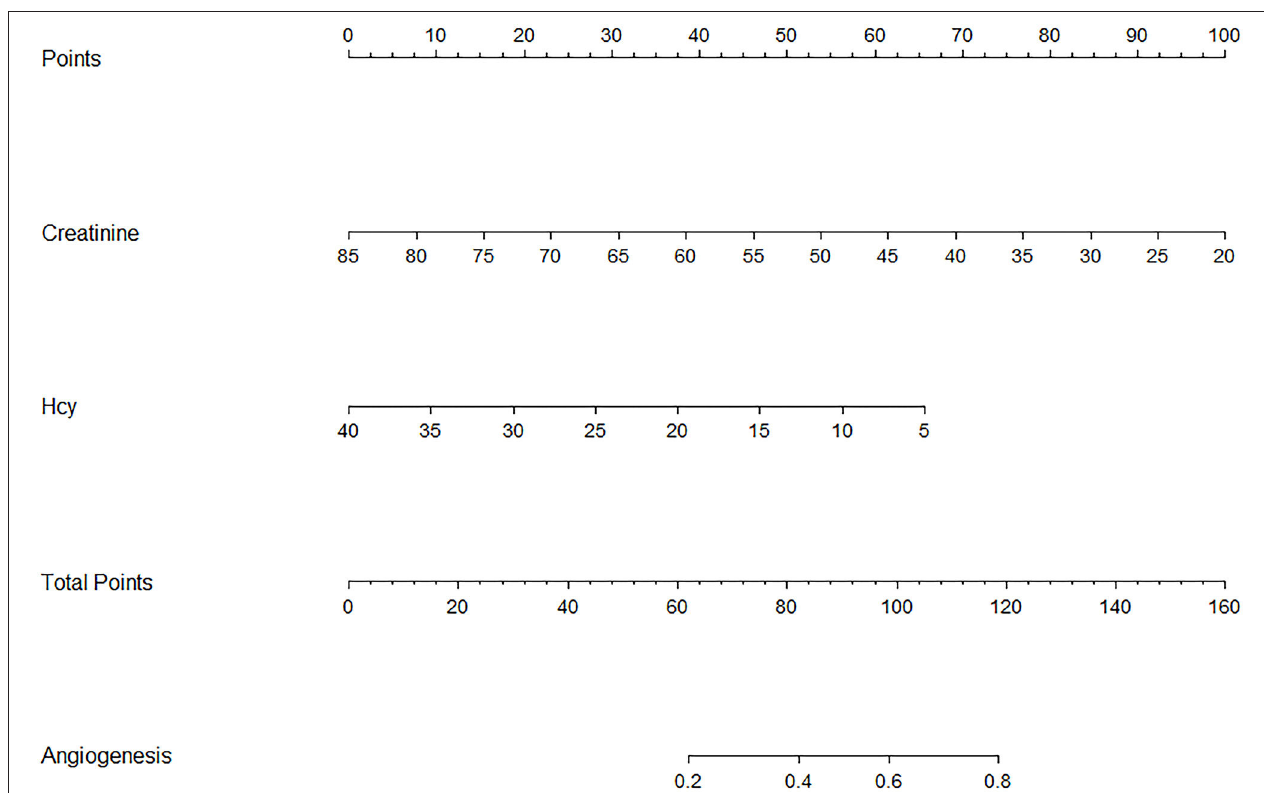
FIGURE 1 | Nomogram of related factors influencing postoperative angiogenesis. Hcy represents homocysteine. Angiogenesis represents the possibility of good postoperative angiogenesis in adult moyamoya disease (MMD) patients.